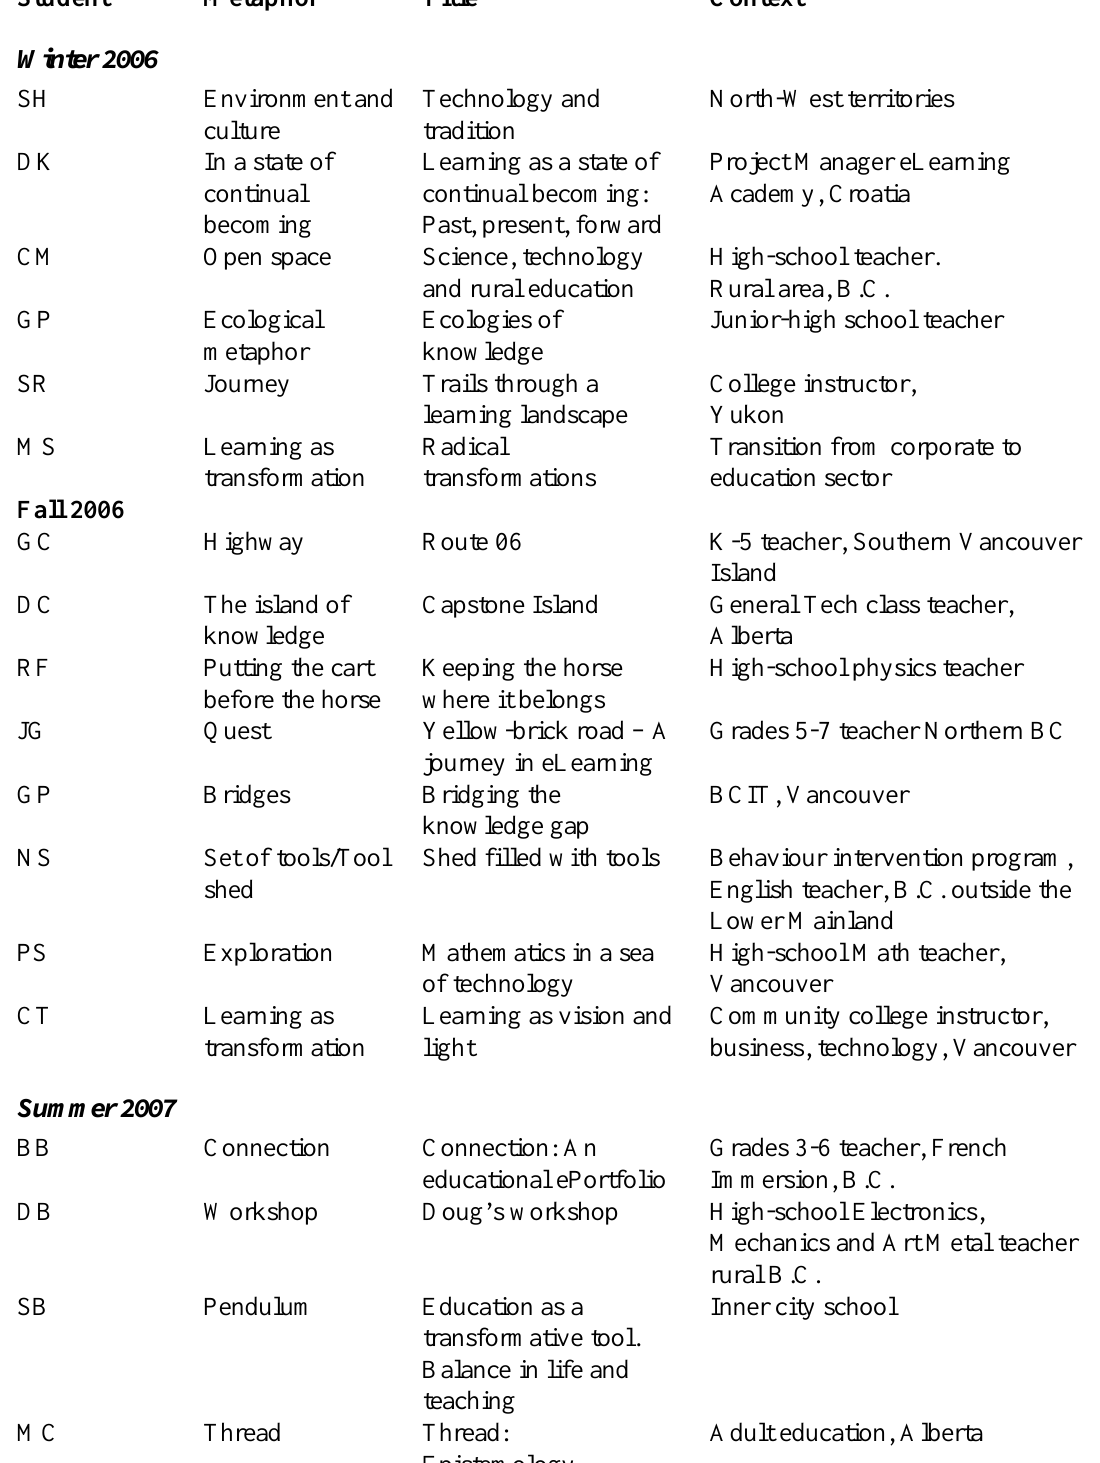
Table 1. Participants, selected metaphors and context